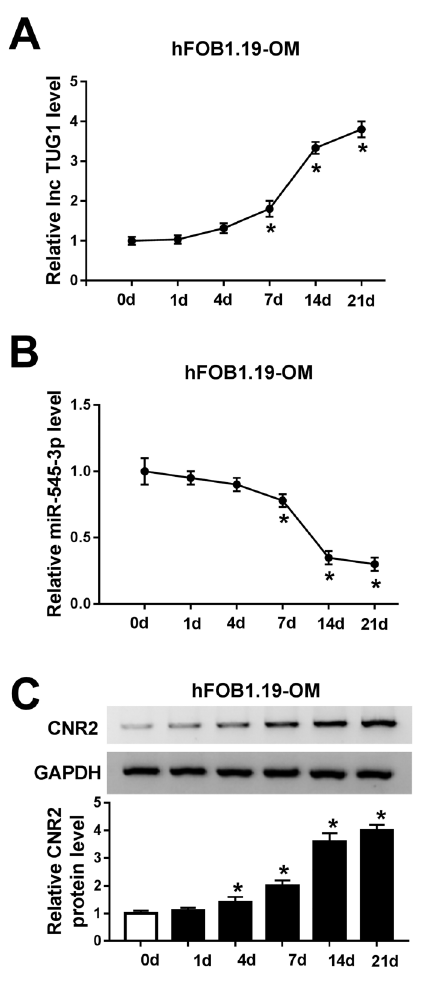
Figure 2. TUG1 and CNR2 were upregulated, while miR-545-3p was down-regulated in osteogenic differentiated hFOB1.19 cells. The hFOB1.19 cells were incubated in osteogenic medium (OM) for 0, 1, 4, 7, 14, or 21 d. A and B , TUG1 and miR-545-3p expression was detected by qRT-PCR. C , CNR2 protein level was examined by western blot assay. Data are reported as means ± SD of three independent experiments. *P o 0.05